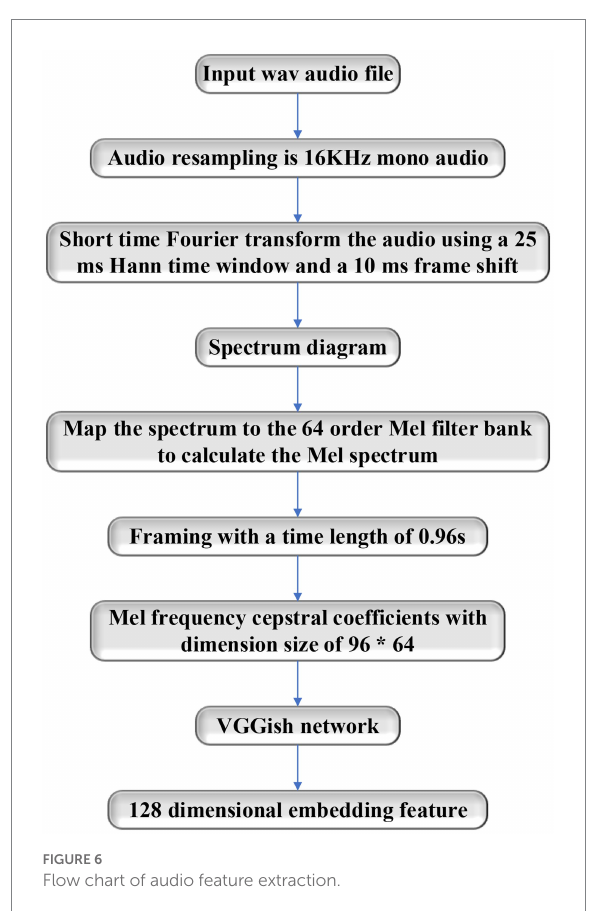
FIGURE 6 Flow chart of audio feature